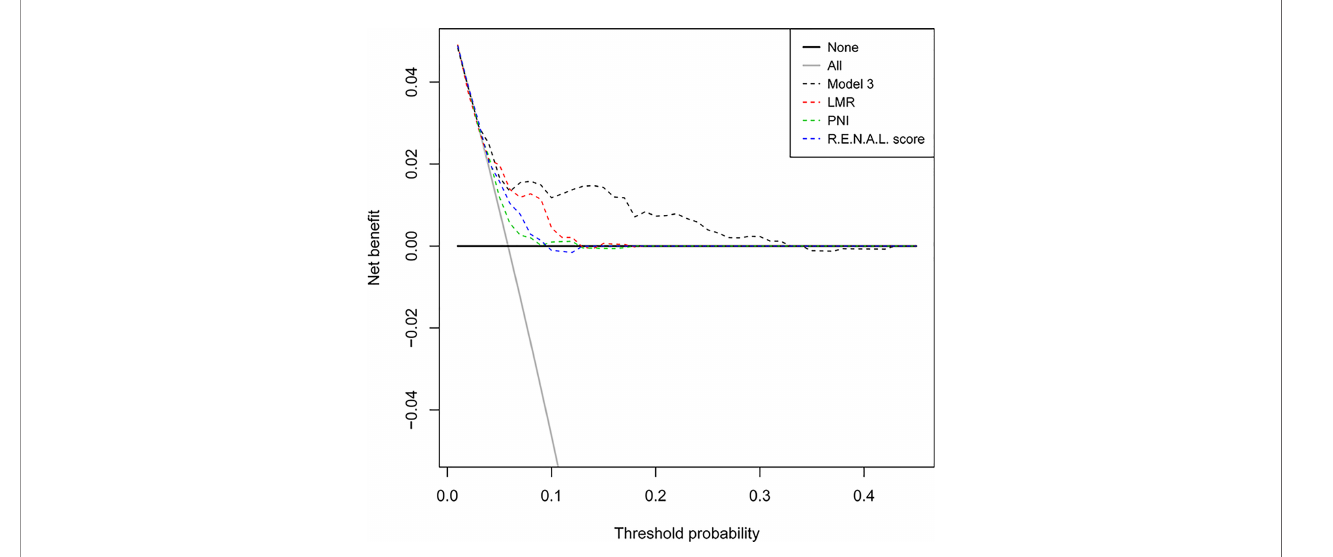
FIGURE 4 | Decision-curve analyses demonstrating the net bene fi t associated with the use of the models for the prediction of